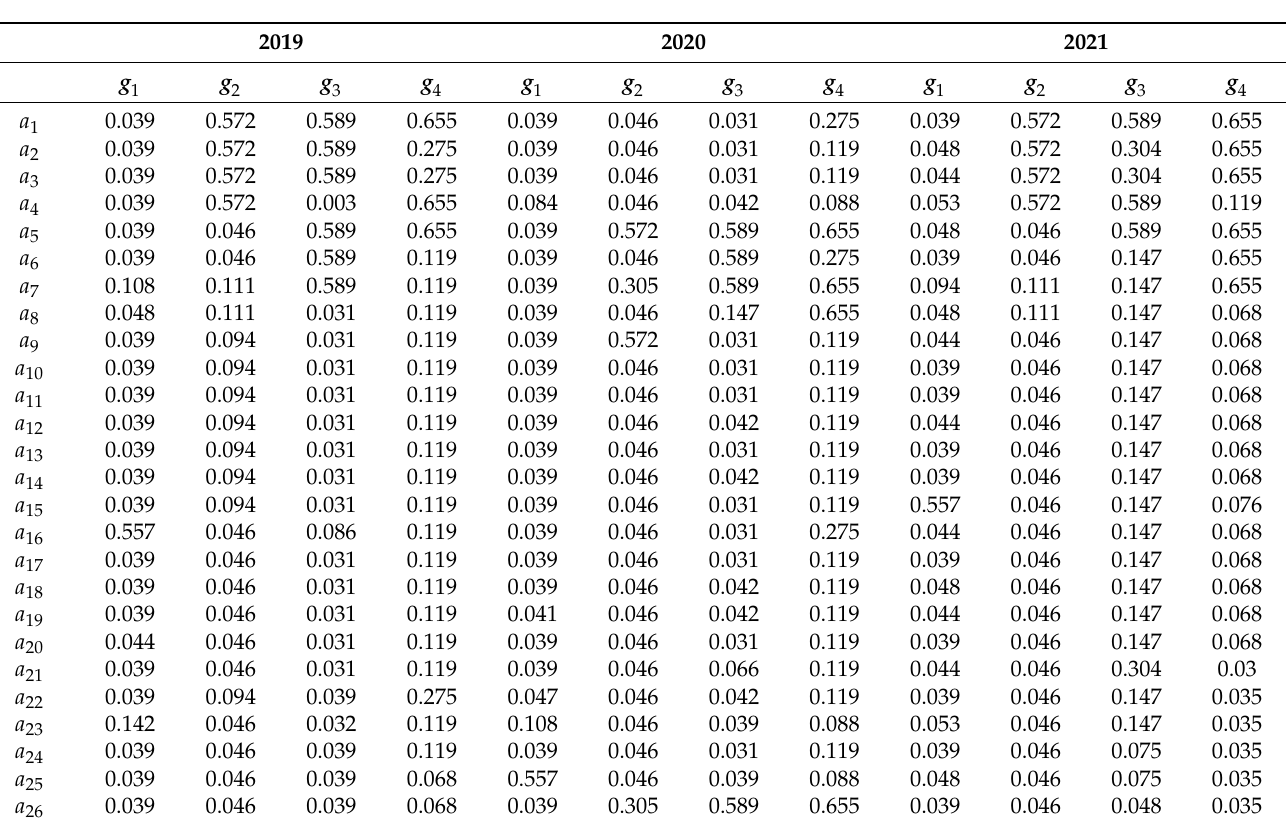
Table A3. Local priority v i for 2019, 2020 and 2021.